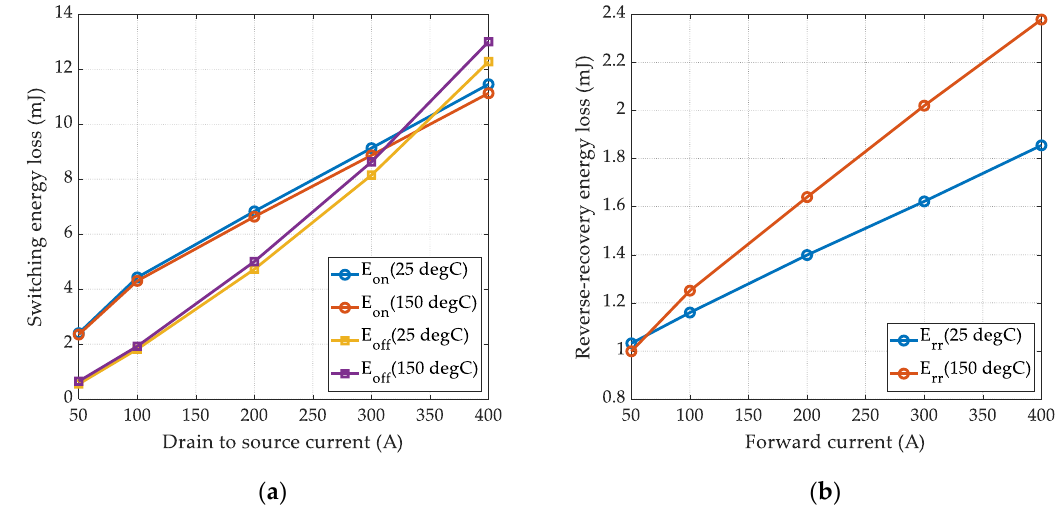
Figure 3. Semiconductor characteristics ( a ) switching energy dissipation of SiC MOSFET, ( b ) reverse recovery energy dissipation of diode.